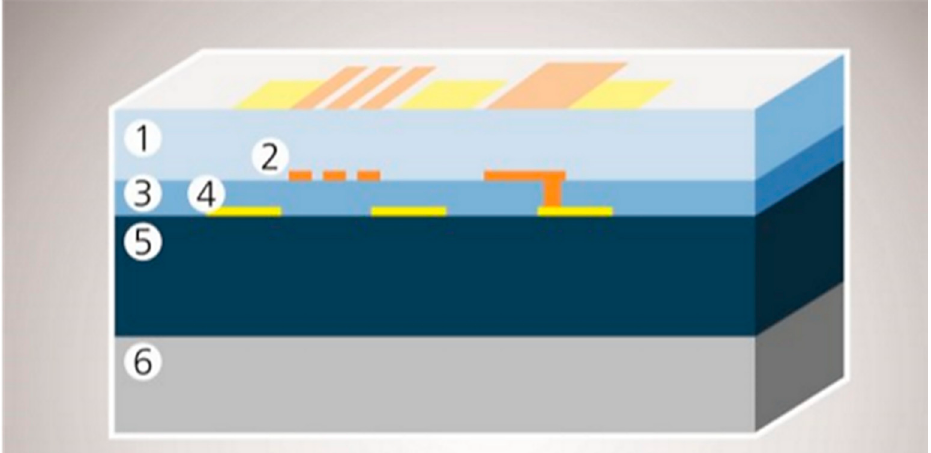
Figure 1. Schematic description of the multifunctional thin film layer system.